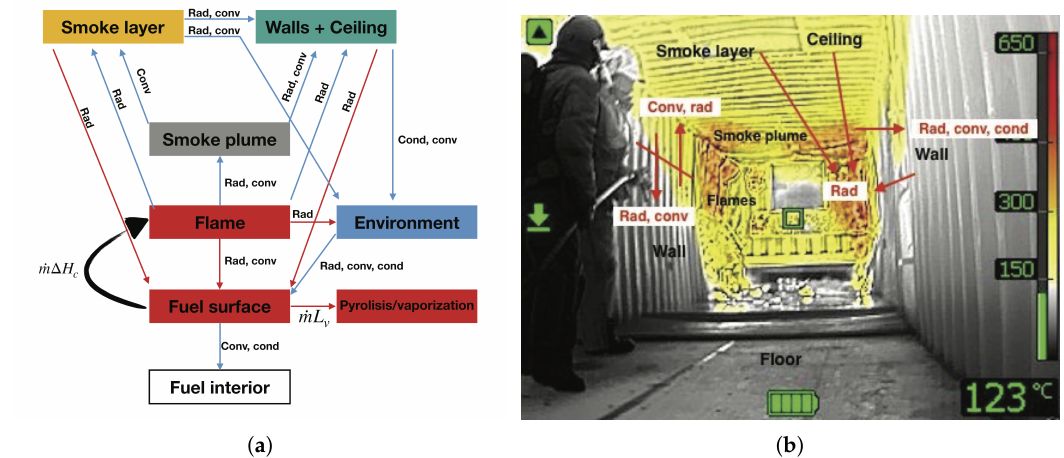
Figure 3. Enclosure effects on heat transfer in a fire container. ( a ) Schematic overview: Blue arrows indicate heat transfer, which is not used in the fire process; ‘rad’ refers to radiation, ‘cond’ refers to conduction and ‘conv’ refers to convection. The curved arrow refers to the mass flow rate of combustible gases [5]. ( b ) Thermal image of enclosure effects in a fire container during a firefighting training at San Vicente Fire Station, Alicante,